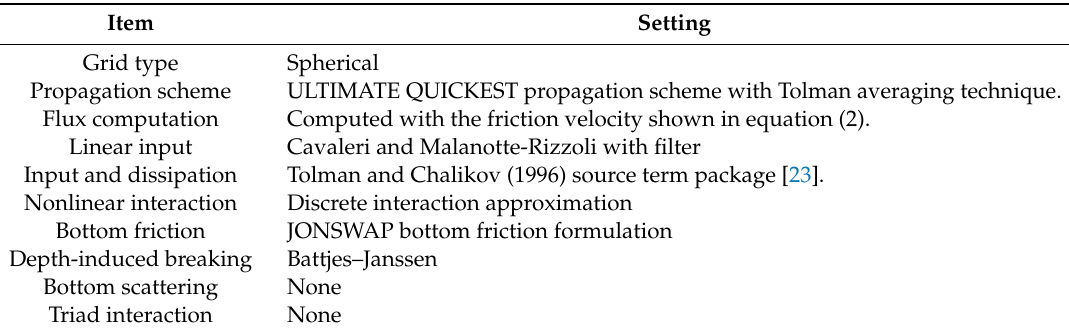
Table 2. Settings of WaveWatch III